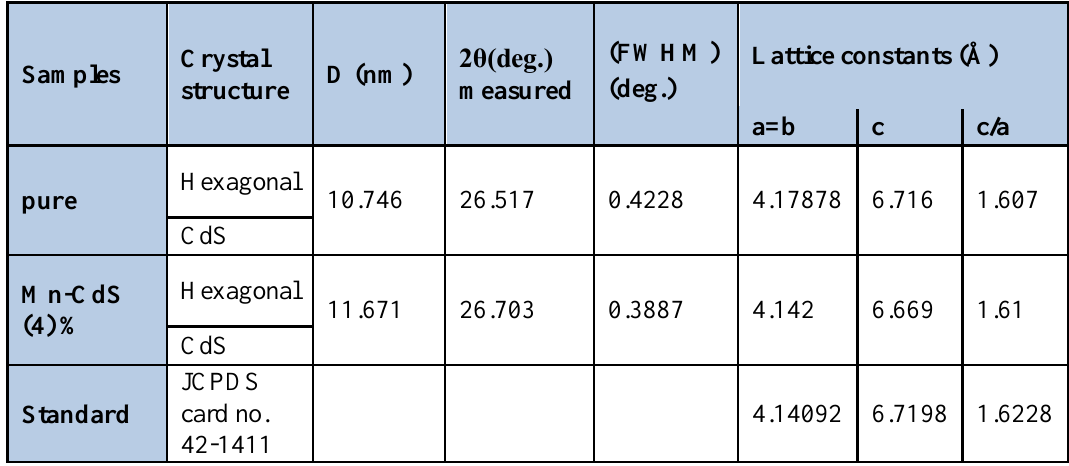
Table 1: Crystallite size, the position of diffraction peaks (2θ), FWHM, and lattice constants of CdS, thin films synthesized at 150 ºC for undoped and 4% Mn-doped